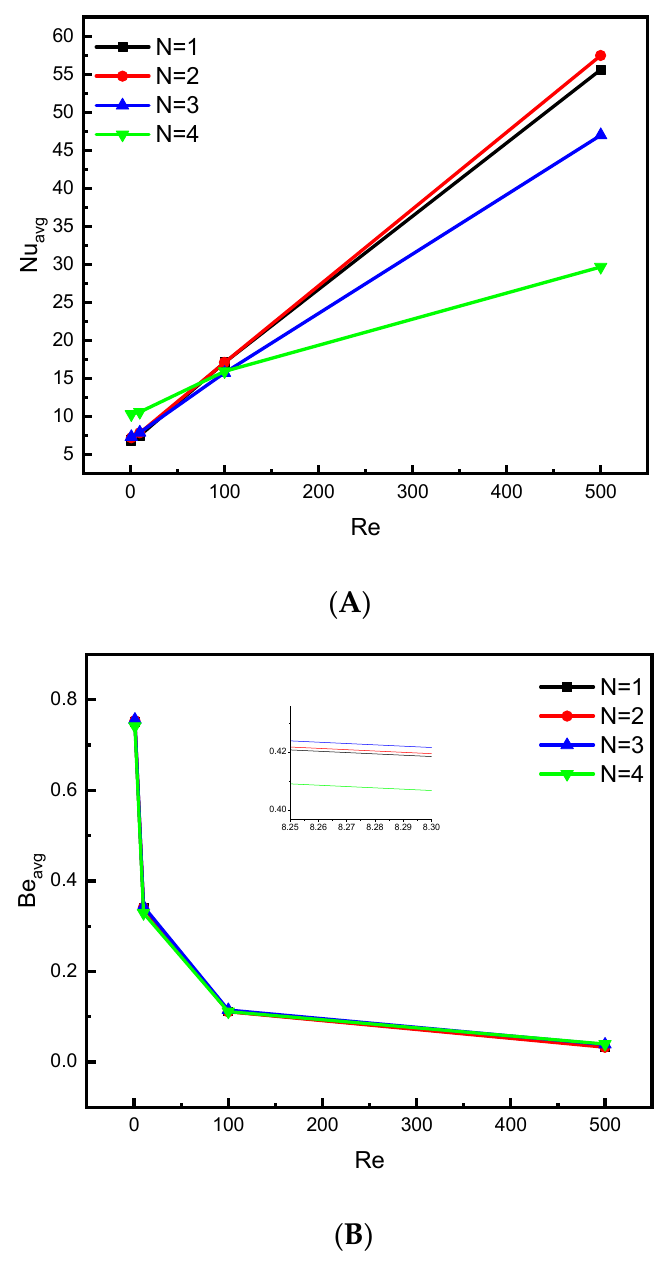
φ= and Ha = 0, Da = 10 − 2 . Figure 9. Effect of N on ( A ) Nu avg and ( B ) Be avg for φ = 0.04 and Ha = 0, and Ha = 0, Da = 10 − 2